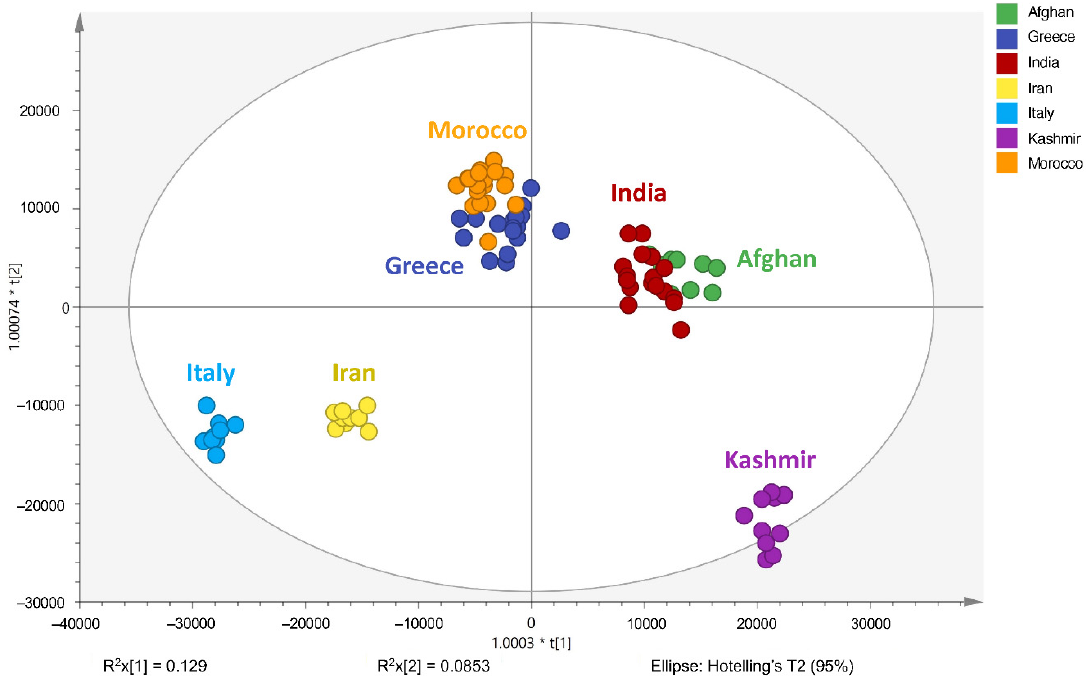
Figure 3. Orthogonal Projections to Latent Structures Discriminant Analysis (oPLS-DA) ( Par scaling ) of the seven saffron species examined.